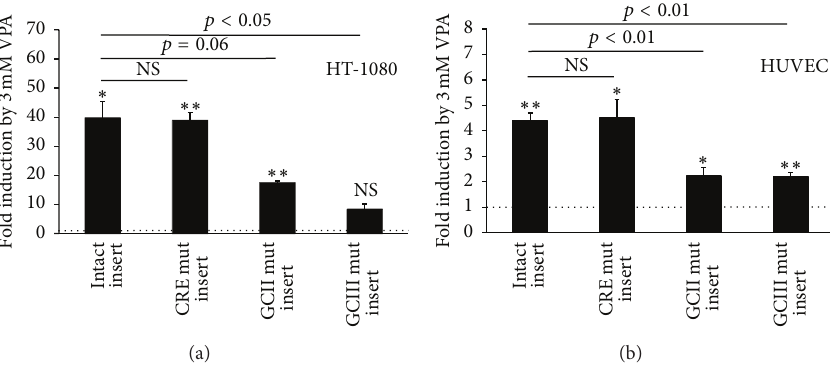
Figure 3: Induction of t-PA reporter construct by VPA and its dependence on proximal GC boxes. HT-1080 (a) and HUVEC (b) cells were cotransfectedwithafireflyluciferaseconstructcontainingdifferentvariantsofa318 bpinsertofthet-PAproximalpromoterandaSV40driven pGL4.73 renilla luciferase control vector. Firefly luciferase signals were normalized to renilla luciferase and the figures show relative data and mean values of three (HT-1080) and four (HUVEC) independent experiments. The variants of the t-PA insert were unmutated (intact), CRE mutated, GC box II mutated, and GC box III mutated. After overnight incubation, cells were stimulated with 3 mM VPA for 24 h. Data are presented as relative inductions of respective construct upon stimulation with VPA, where the dotted line in each figure represents untreated controls (=1). Statistical evaluation was performed using paired Student’s 𝑡 -test and comparisons are relative to respective untreated control. The marks indicate the statistical comparison of the VPA-induction in the t-PA construct with intact insert versus the inductions of respective mutated insert. ∗ 𝑝 <0.05 ; ∗∗ 𝑝 < 0.01 and NS =